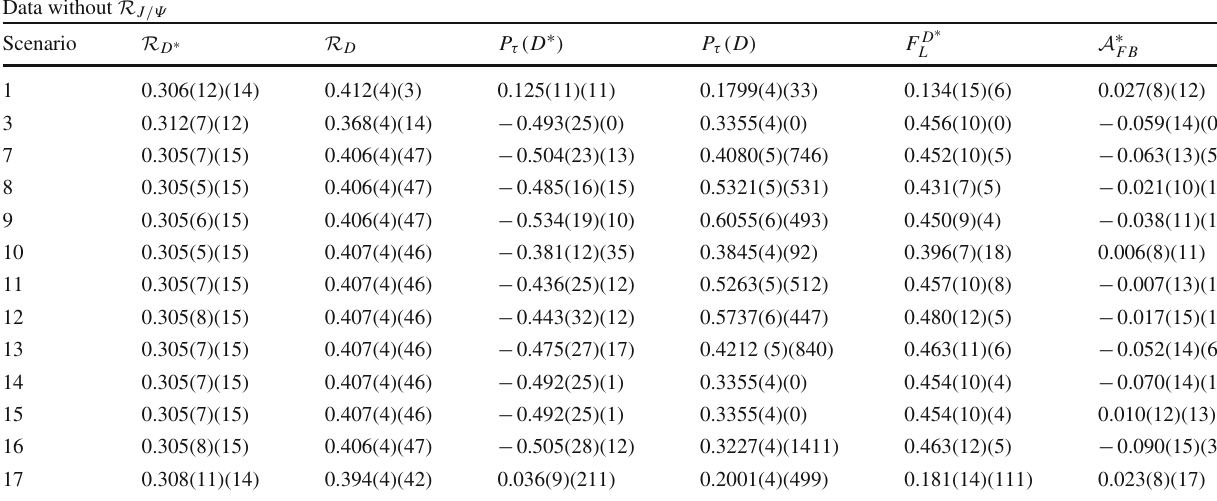
Table 8 Predictions for observables listed in Table 1, for different sce- narios listed in the first dataset of Table 7. We have omitted the scenario where the best fit is a contour instead of a curve (scenario 2). Each result contains two uncertainties: the first one for uncertainties in form factors